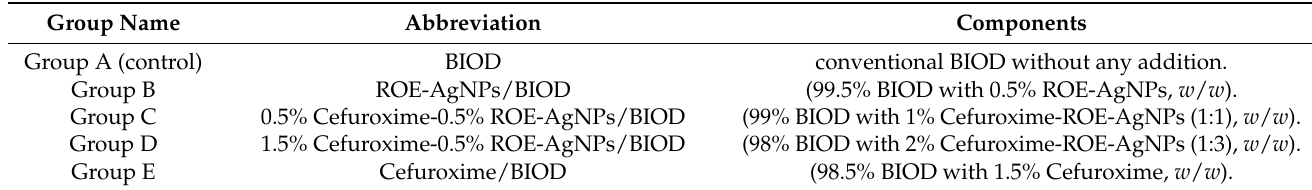
Table 2. Proportion of the experimental materials added to Conventional BIOD